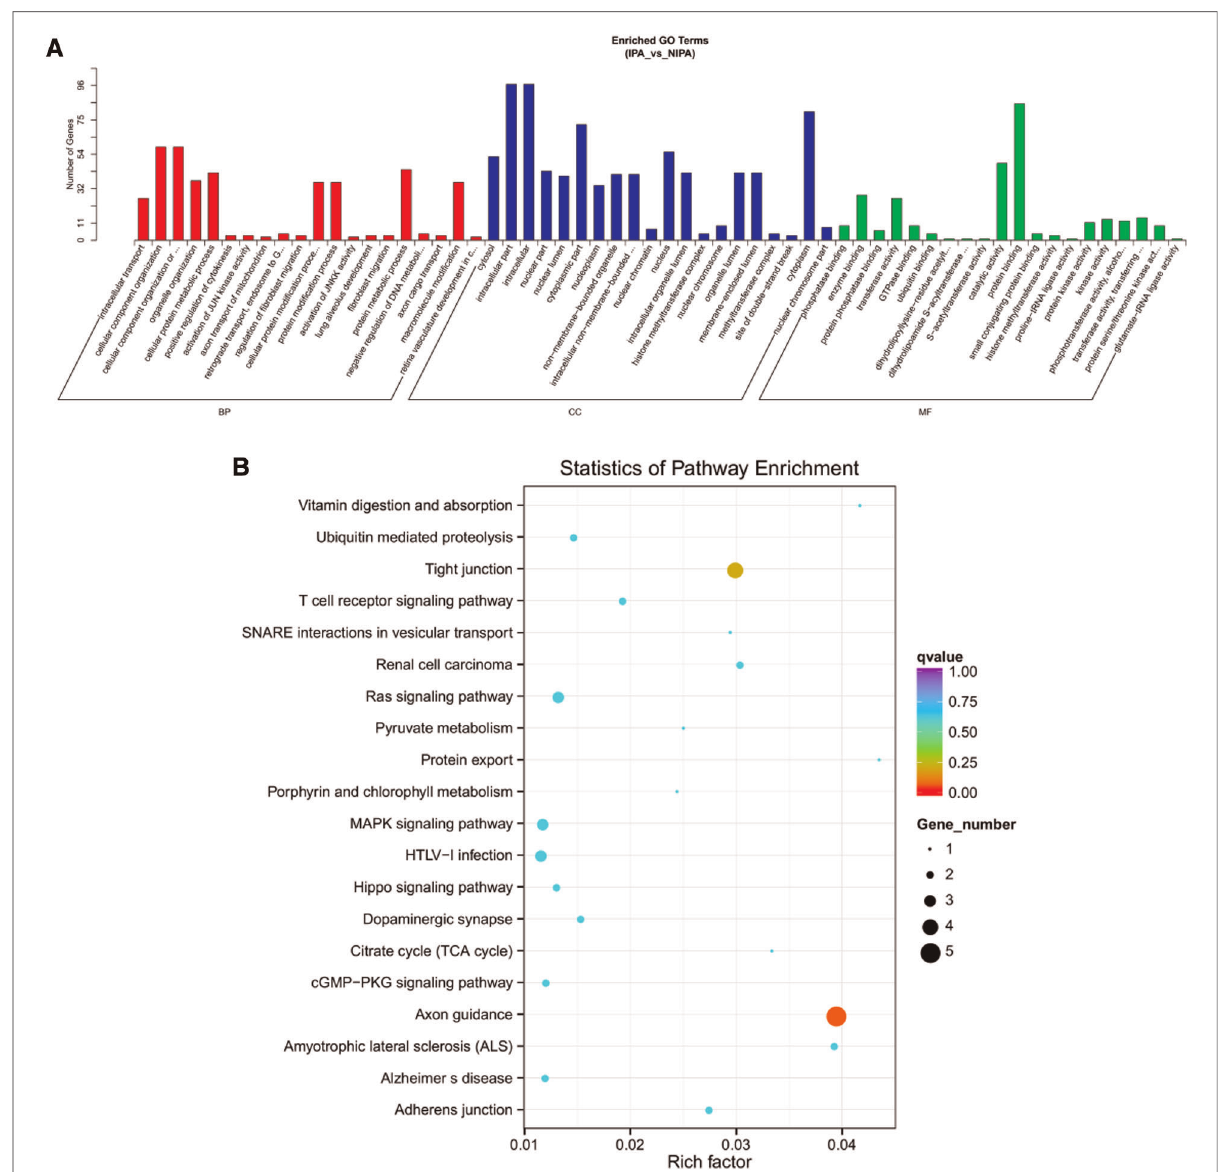
FIGURE 3 DEcircRNA target gene enrichment analysis. ( A ) GO function enrichment bar chart of the top 20 enriched items. Abscissa denotes GO entry: BP, biological process; CC, cellular component; MF, molecular function represented by different color bars; ordinate is the number of genes enriched by GO entry. ( B ) KEGG pathway enrichment bubble